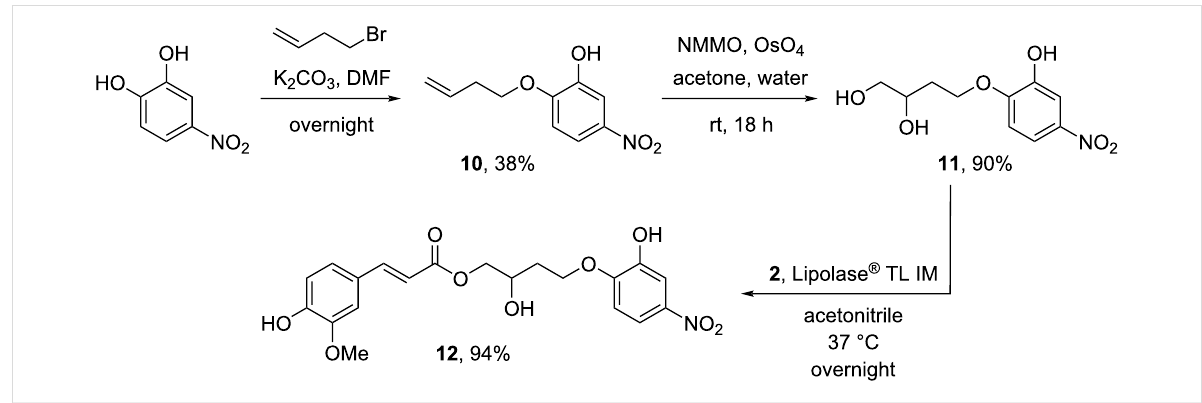
Scheme 1: Chemoenzymatic synthesis of (±)-4- O -(2-hydroxy-4-nitrophenyl)-1- O - trans -feruloyl-1,2,4-butanetriol (4NTC–linker–Fe, 12 ).